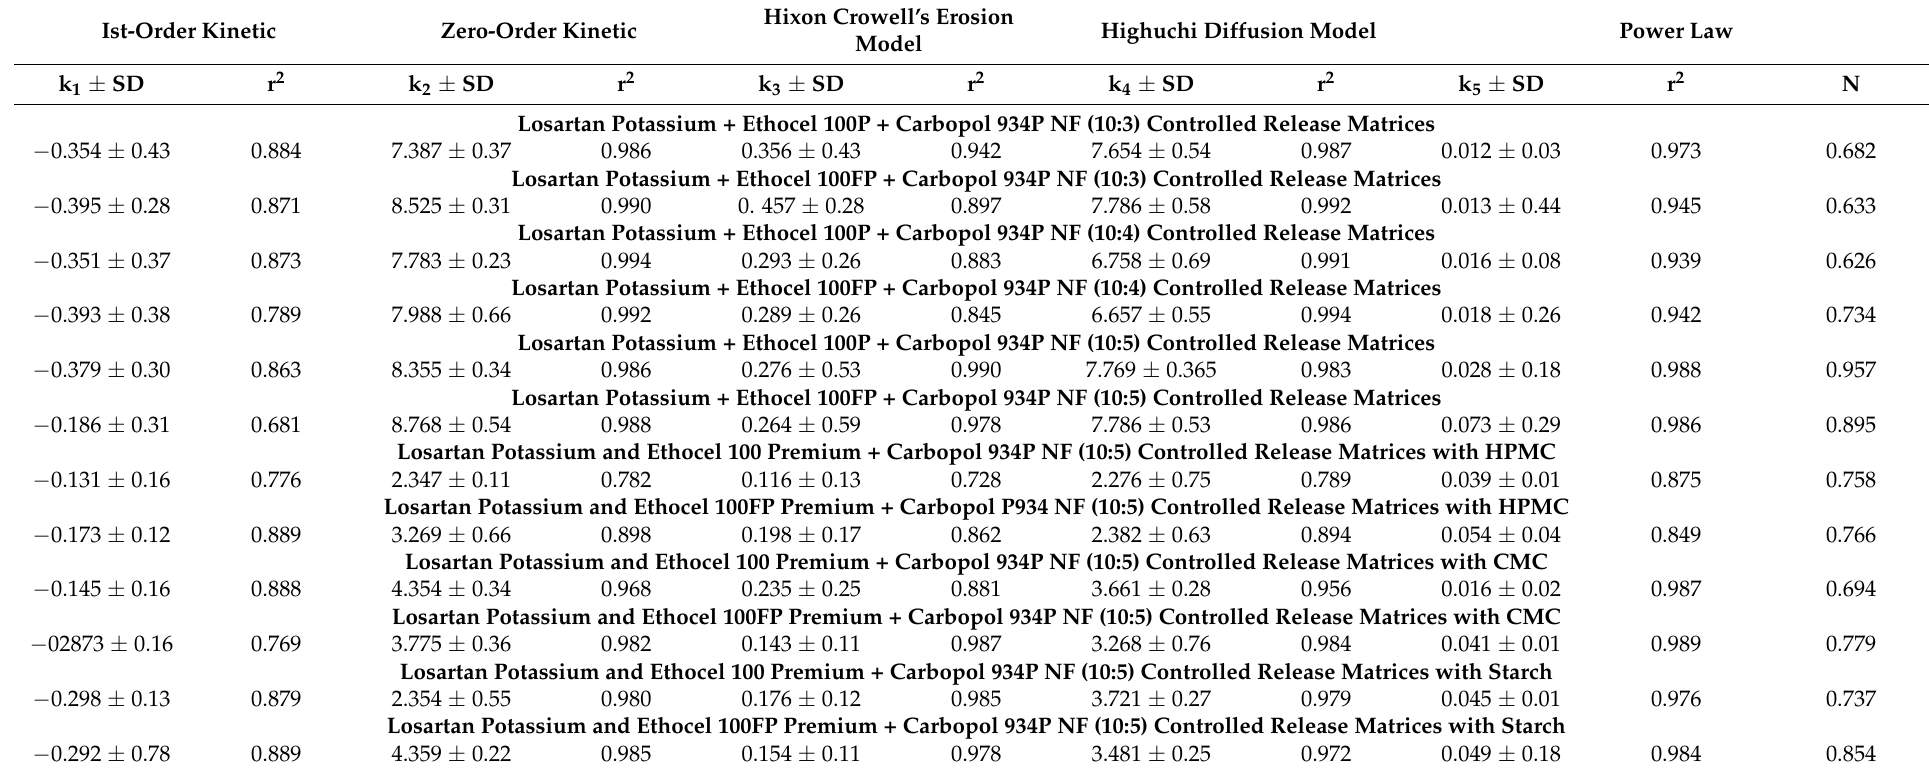
Table 5. Drug release